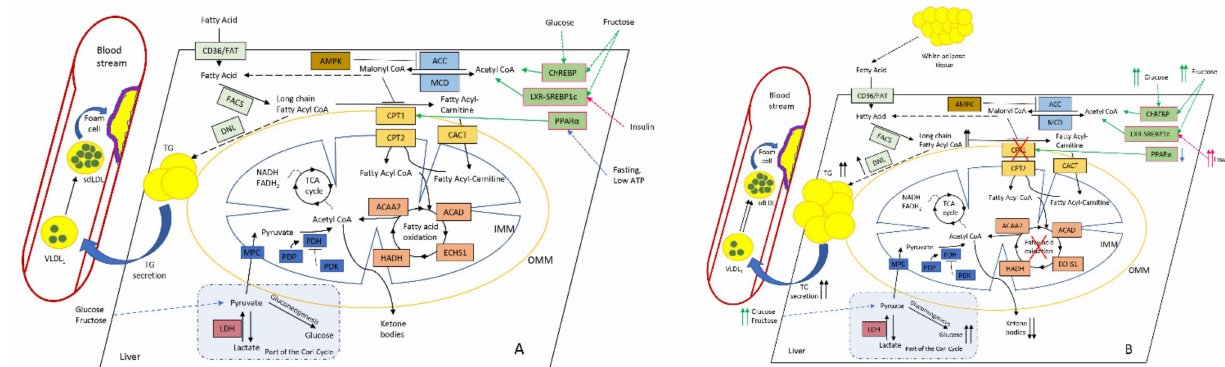
Figure 1. Altered hepatic lipid metabolism in normal ( A ) and NAFLD ( B ) conditions. Increased diet supply of glucose and fructose affects ChREBP (carbohydrate-responsive element-binding protein), SREBP1c (sterol regulatory element-binding protein-1c), and LXR (liver X receptor) TFs, which stimulate malonyl CoA synthesis. PPAR α (peroxisome proliferator- activated receptor alpha) normally activates CPT1 under fasting and low-ATP conditions [58]. As a key intermediate, malonyl CoA inhibits CPT1, thus reducing FAO. This leads to the accumulation of long-chain fatty-acid CoA (which could also be delivered from surplus adipose tissue), and stimulates DNL with the subsequent rise in intrahepatic TG and plasma TG levels, further increasing large VLDL 1 and the formation of small dense LDL, which favours foam cell formation and ultimately atherosclerosis. During the progression of NAFLD, the production of ketone bodies progressively reduces while hepatic glucose synthesis and output increases, thus further promoting IR and the rise in insulin level [59]. Colour coding as follows: PPAR α and other TFs are depicted in pale green; primarily FA-metabolising enzymes (FAT (fatty-acid translocase) and FACS (fatty-acid synthase)) and DNL (de novo lipogenesis) are highlighted in pale blue; malonyl-CoA-metabolising enzymes ACC (acetyl-CoA carboxylase) and MCD (malonyl-CoA decarboxylase) are highlighted in blue; CPT system enzymes (CPT1, CPT2, and CACT) are depicted in light brown; AMPK (AMP-activated protein kinase), the main regulator of CPT system are depicted in brown; FAO enzymes ACAA2 (acetyl-CoA acyltransferase 2), ACAD (acyl-CoA dehydrogenase), ECHS1 (enoyl-CoA hydratase, short chain 1), and HADH (hydroxyacyl-CoA dehydrogenase) are depicted in in pale red; pyruvate metabolism enzymes MPC (mitochondrial pyruvate carrier 1), PDP (pyruvate dehydrogenase phosphatase), PDH (pyruvate dehydrogenase), and PDK (pyruvate dehydrogenase kinase) are depicted in dark blue; and LDH (lactate dehydrogenase) is depicted in red. Abbreviations: IMM and OMM, inner and outer mitochondrial membrane,